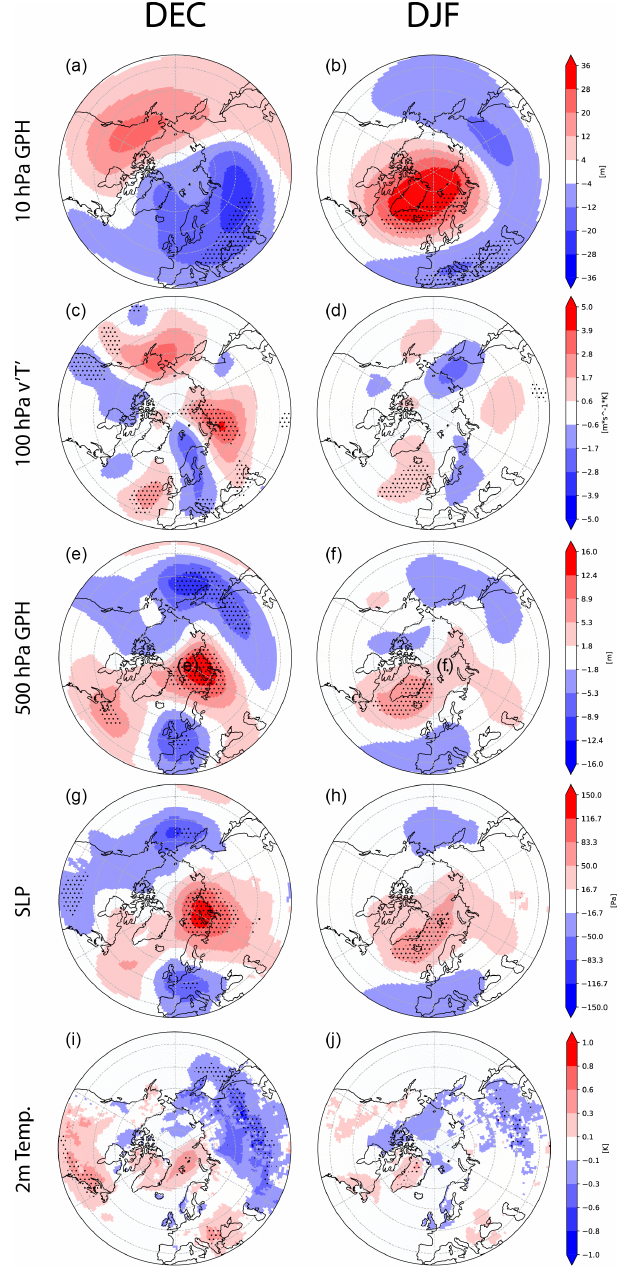
Figure 6. Averaged anomalies in 1901–2010 between high-dipole and low-dipole ASF-20C EXP ensemble means for December (a, c, e, g, i) and DJF (b, d, f, h, j) : (a, b) 10hPa geopotential heights, (c, d) 100hPa meridional eddy heat flux, (e, f) 500hPa geopotential heights, (g, h) sea level pressure and (i, j) 2m temperature. Stip- pled areas represent 90% significance. For monthly anomalies see Fig.